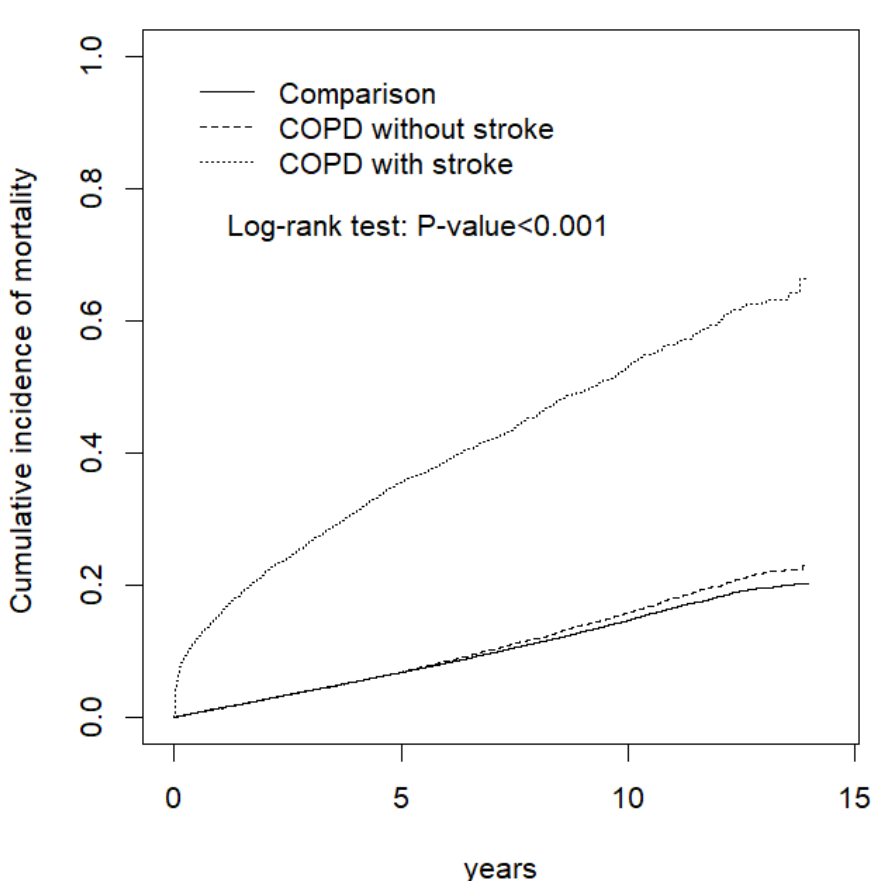
Figure 1. Comparison of the cumulative incidence of mortality among the COPD with stroke, COPD without stroke, and comparison subgroups.